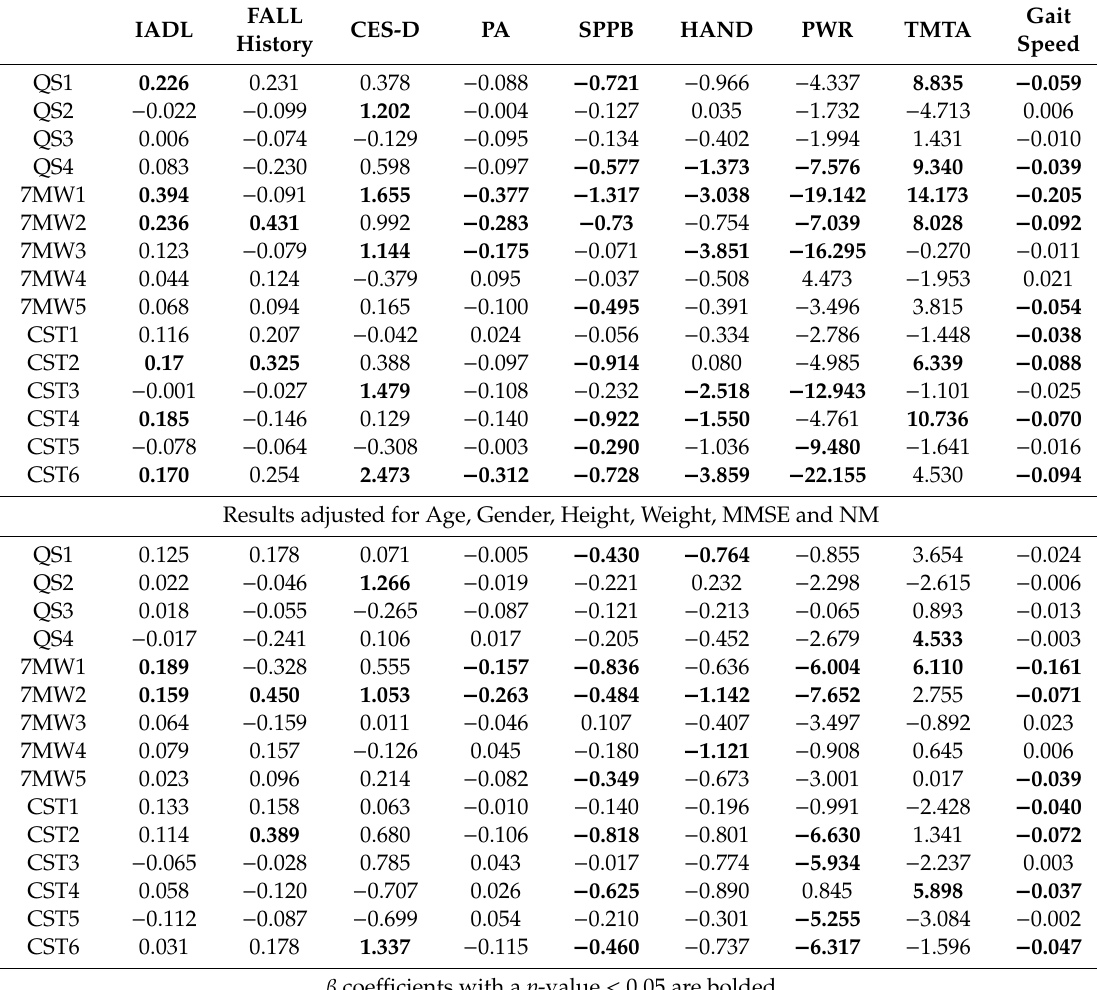
Table 9. Construct validity analysis: Linear regression between domains and health-related measures.